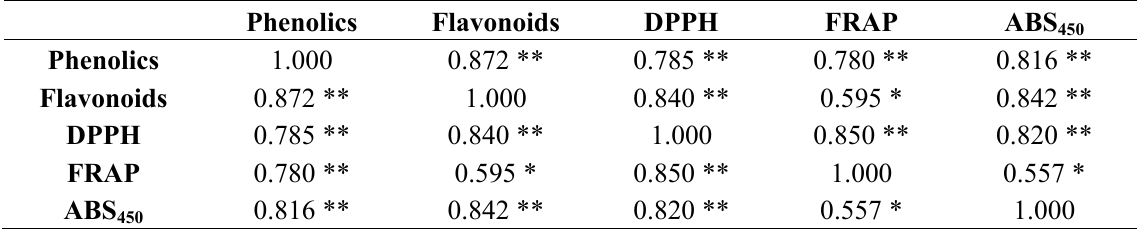
Table 1. Correlation matrix showing the correlations between the phenolics, flavonoids, DPPH scavenging, FRAP, and ABS 450